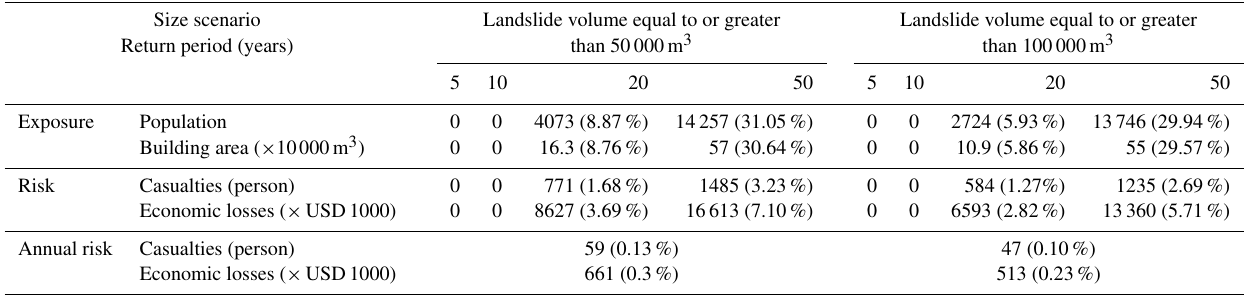
Table 6. Exposure and risk of buildings and population for landslides under four return periods (5, 10, 20, and 50 years) and two size scenarios (landslide volume equal to or greater than 50000 or 100000m 3 ) by using the methodology in Sect. 3.2 and 3.3. (Number in brackets is in